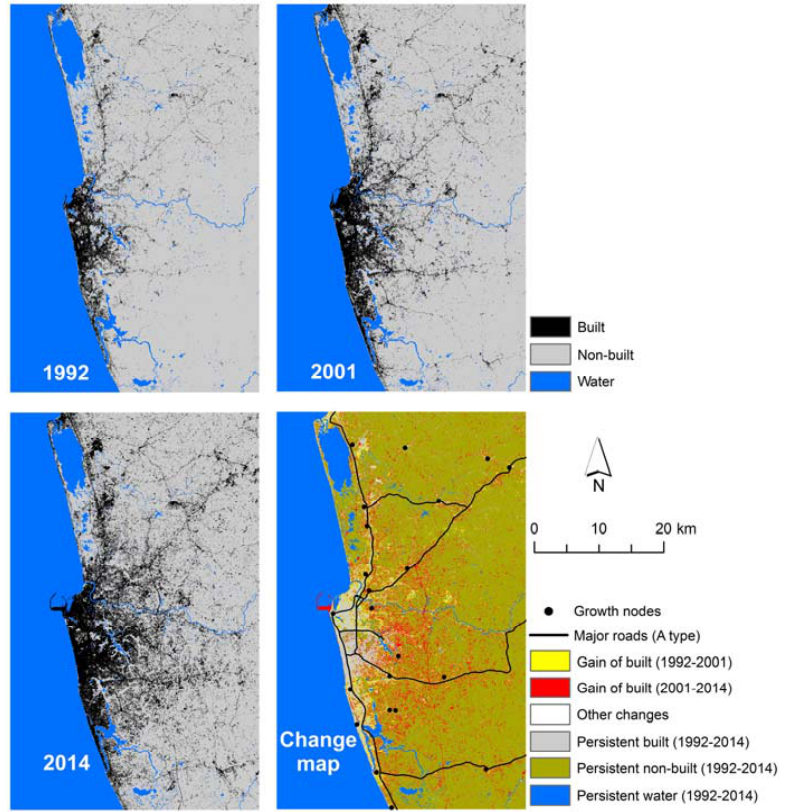
Figure 2. Land-use/cover maps of the CMA (1992, 2001, and 2014) and the detected ULCs.